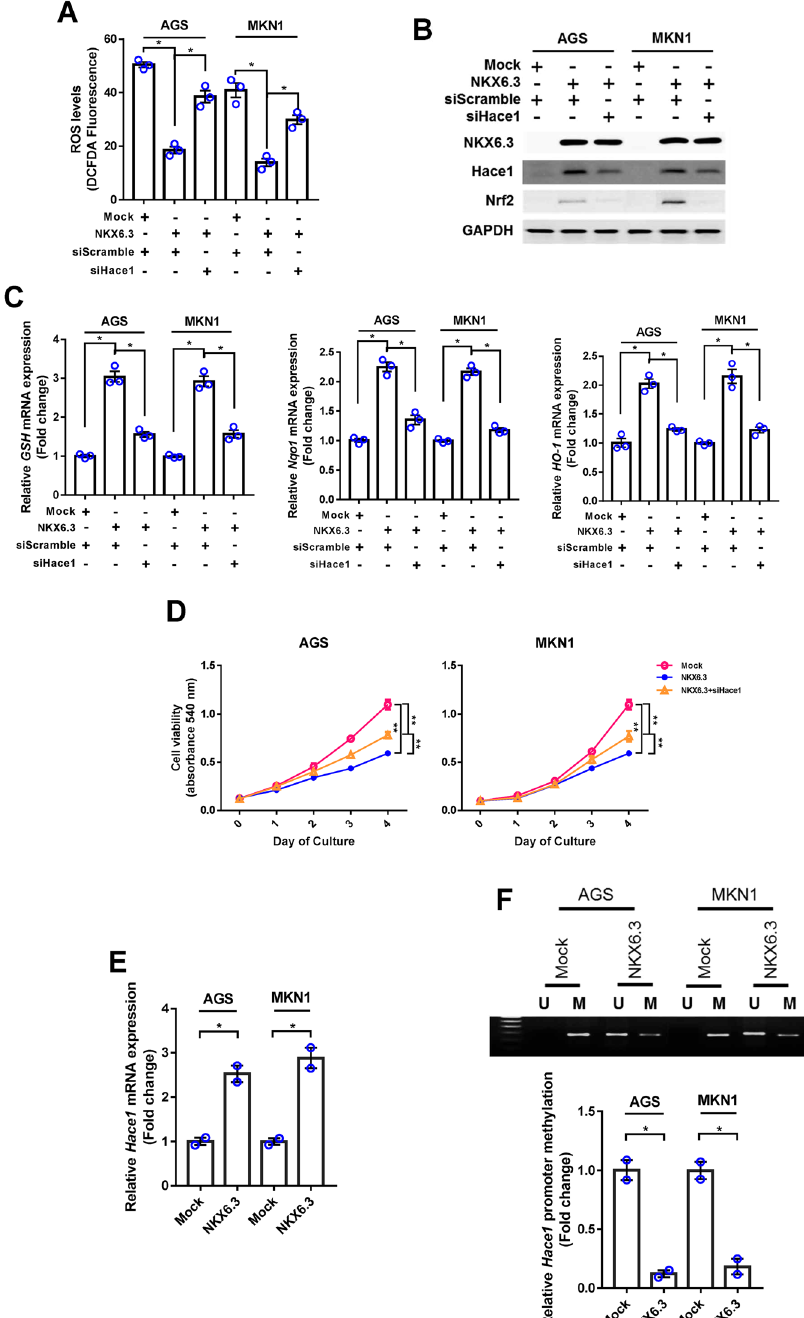
Figure 2. NKX6.3 increases Hace1 expression by inducing demethylation of Hace1 promoter. (A) In DCFDA staining analysis, knock-down of Hace1 partially recovered ROS production in NKX6.3 stable cells. Results are represented as mean ± SEM from three independent experiments. (B) In NKX6.3 stable cells, knock-down of Hace1 reduced Nrf2 expression in western blot analysis. (C) In real-time PCR analysis, Hace1 silencing resulted in decreased GSH , Nqo1 and Ho-1 mRNA expression in NKX6.3 stable cells. Results are represented as mean ± SEM from three independent experiments. (D) NKX6.3 stable cells showed time-dependent inhibition of cell viability, but knock-down of Hace1 in NKX6.3 stable cells showed recovery of cell viability. Results are represented as mean ± SEM from three independent experiments. (E) NKX6.3 induced the expression of Hace1 mRNA transcript in AGS and MKN1 cells in real-time PCR. Results are represented as mean ± SEM from three independent experiments. (F) Hypermethylation of CpG island at Hace1 promoter was found in mock stable AGS and MKN1 cells, whereas NKX6.3 expression induced demethylation of Hace1 promoter in MSP and real-time qPCR. Results are represented as mean ± SEM from three independent experiments. Each dot plot represents the result from the individual experiment. ** P < 0.01, * P < 0.05, based on the student’s